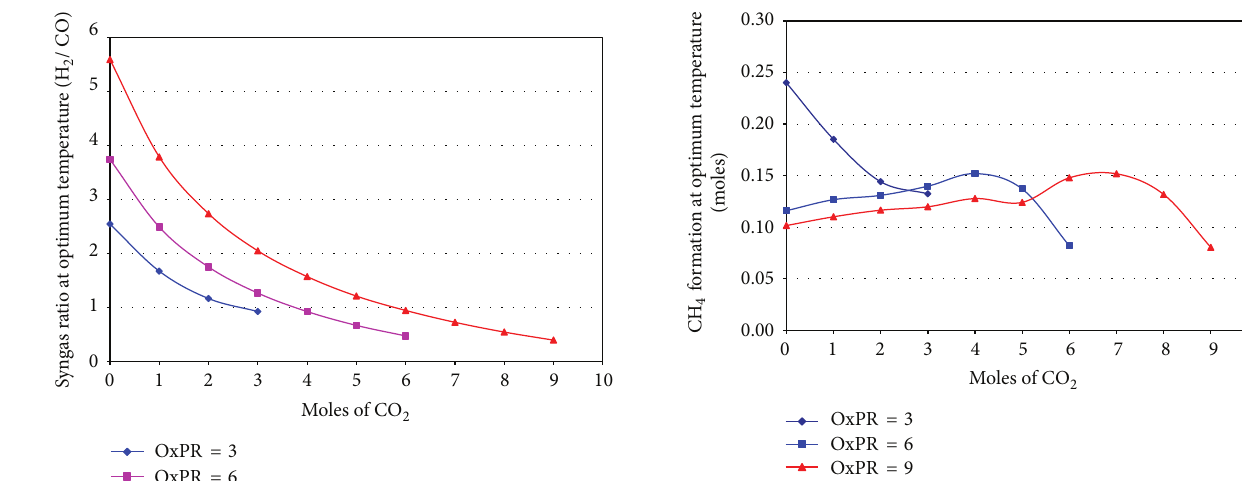
Figure 10: Methane formation at optimum temperature in CR of Propane.